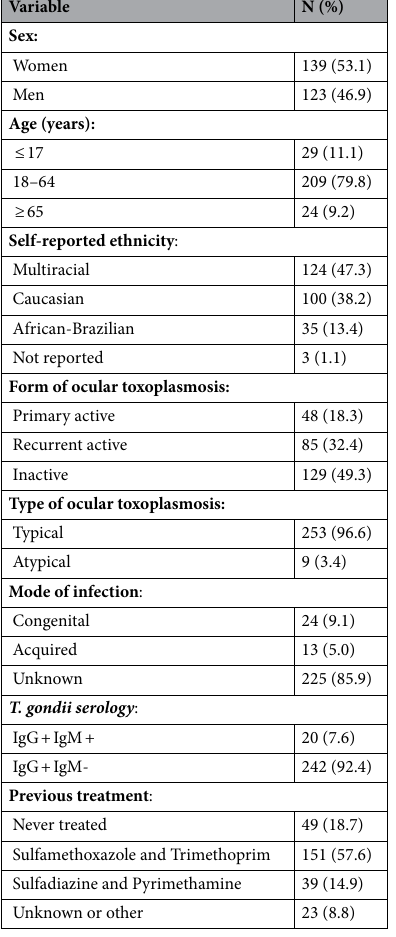
Table 1. Characteristics of the participants (n = 262